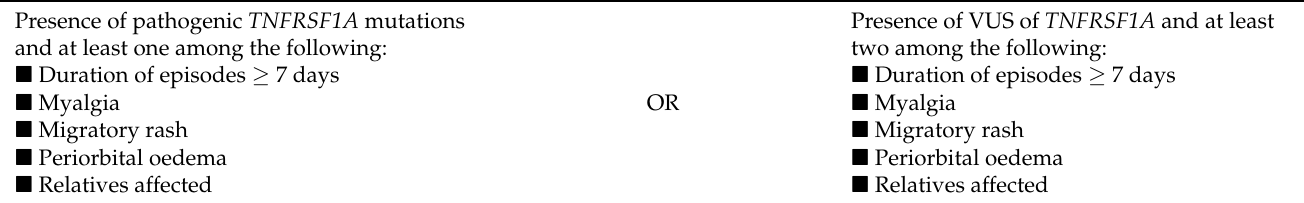
Table 4. New Eurofever/PRINTO Classification Criteria for